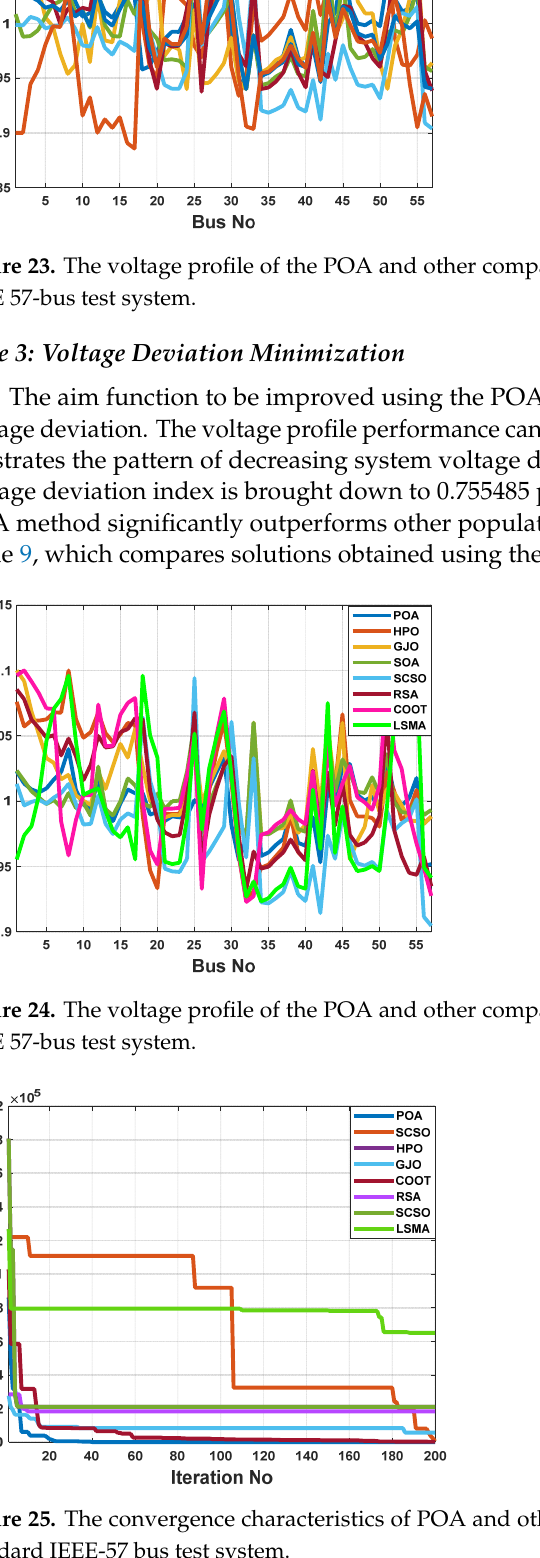
Figure 25. The convergence characteristics of POA and other compared algorithms for case 3 in a standard IEEE-57 bus test system.